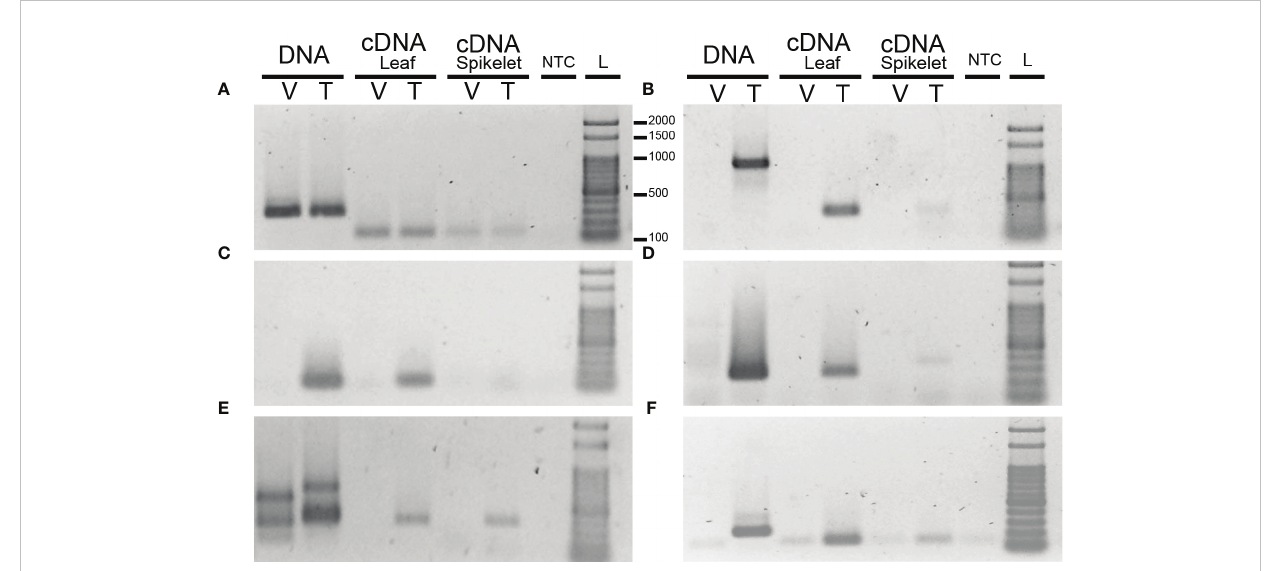
FIGURE 7 PCR ampli fi cation using DNA and cDNA from leaves and spikelets of E . curvula , Victoria (V), and Tanganyika (T) cvs. UBICE (ubiquitin conjugating enzyme transcript) (A) was used as positive control, and primers were designed over the annotated genes (B) ABD1 , (C) PVA12 , (D) MEE66 , (E) ATXR2 , and (F) RECQ4A . NTC (negative control) and L (Ladder). Presence/absence of the fi ve genes was